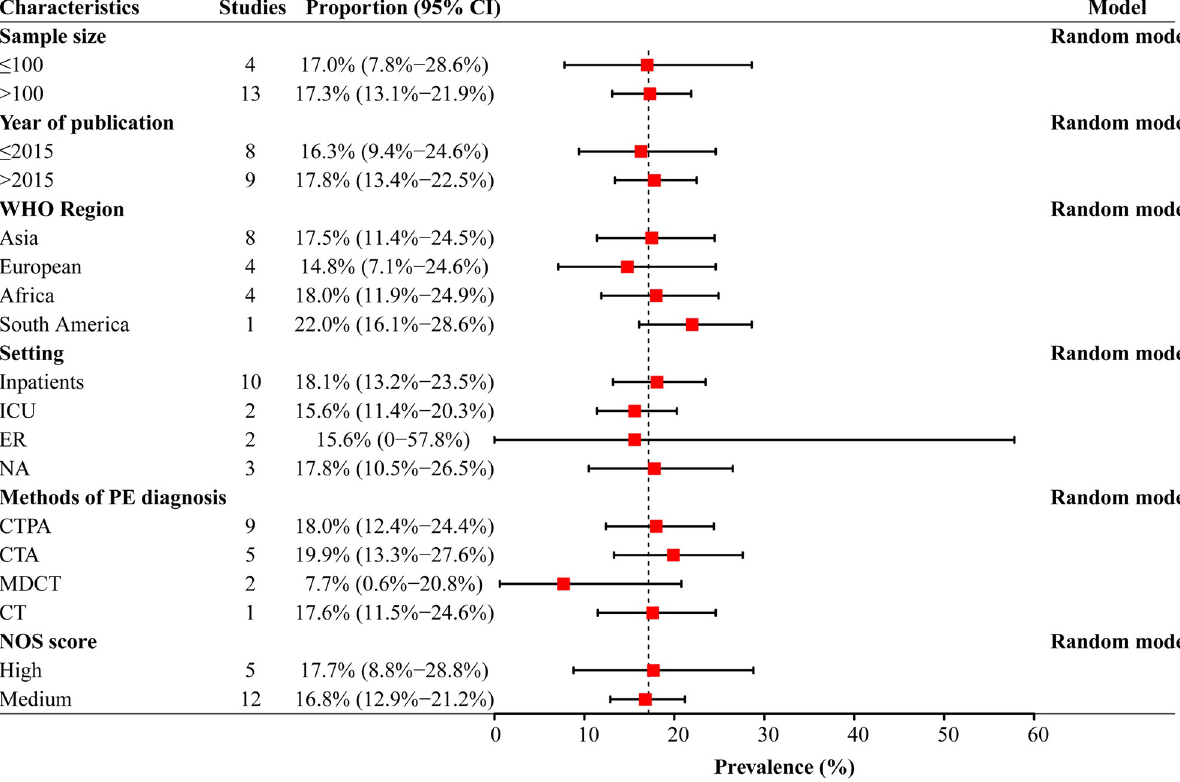
PLOS ONE | https://doi.org/10.1371/journal.pone.0256480 September 2,